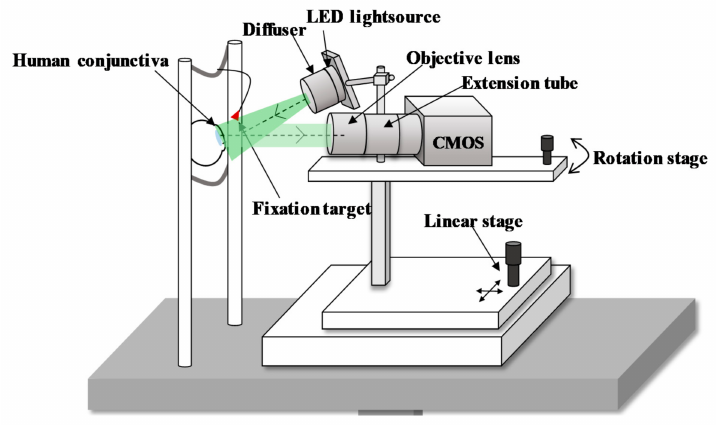
Figure 2. Custom-built optical imaging system for human bulbar